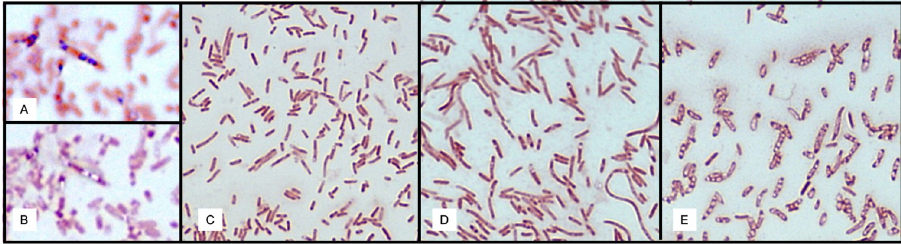
Fig 5. Microscopic observation of PHA accumulation. A: PHA granules stained with Sudan black; B: same slide with fine focus adjustment showing PHA as clear inclusions; panels C-E: representative slides showing the scale used to indicate PHA accumulation; C: no PHA inclusions visible (“-”); D: PHA inclusions seen in some, but not all, cells (“+/-”); and E: PHA inclusions seen in nearly every cell (“+”). In this figure, all panels show E . coli containing pUMS and one of the pDK-series plasmids.